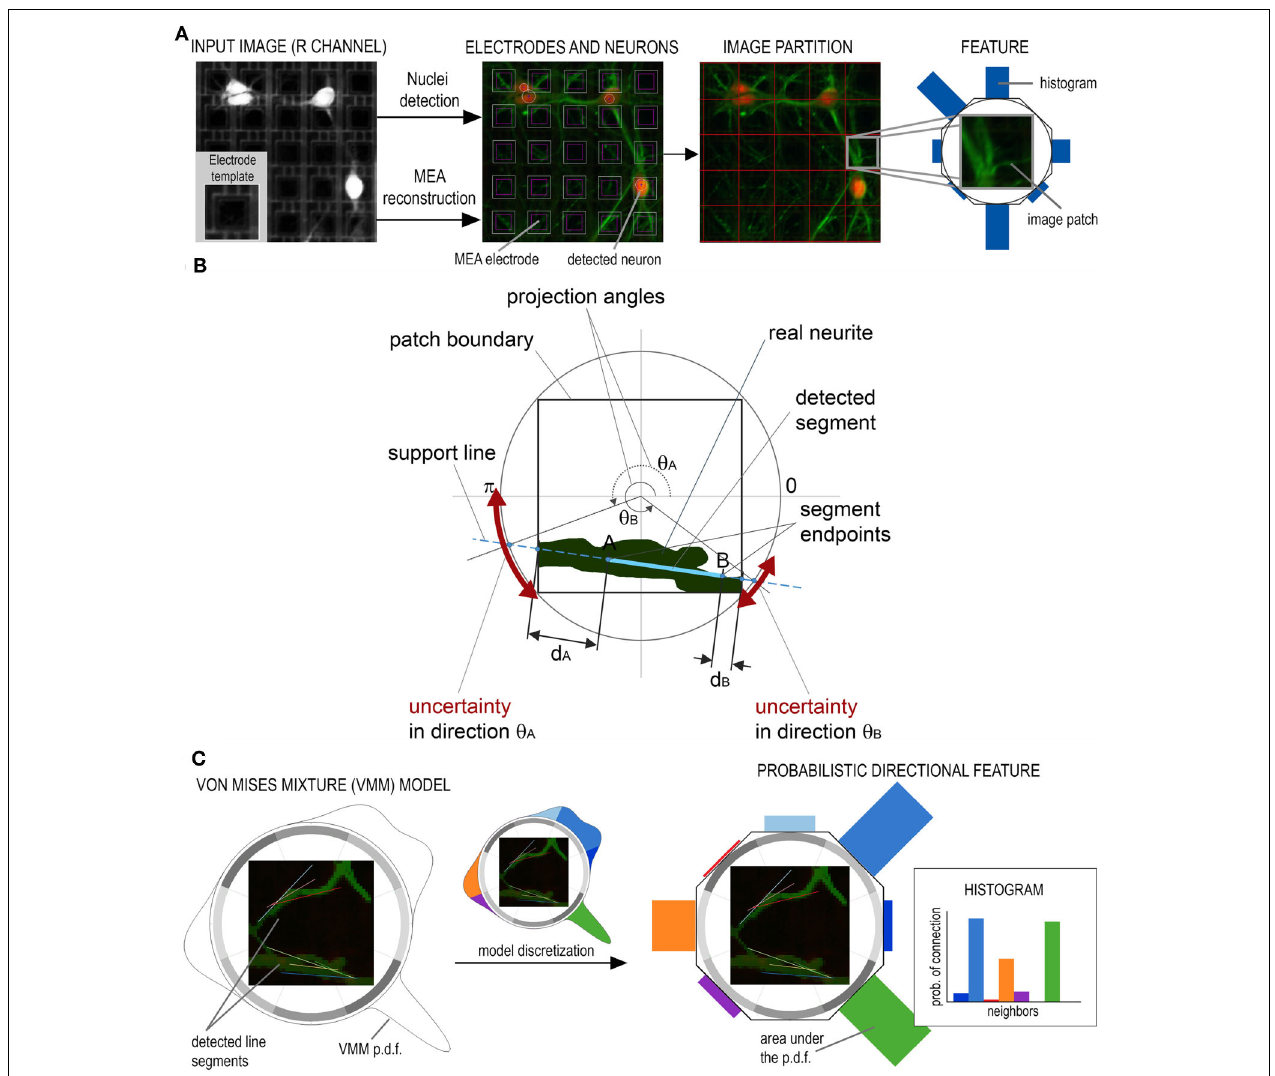
FIGURE 3 | Preprocessing and feature extraction. (A) The Micro Electrode Array reconstruction is used to partition the image into small patches corresponding to the electrode areas. (B) A Von Mises Mixture (VMM) model is fitted to a set of segments